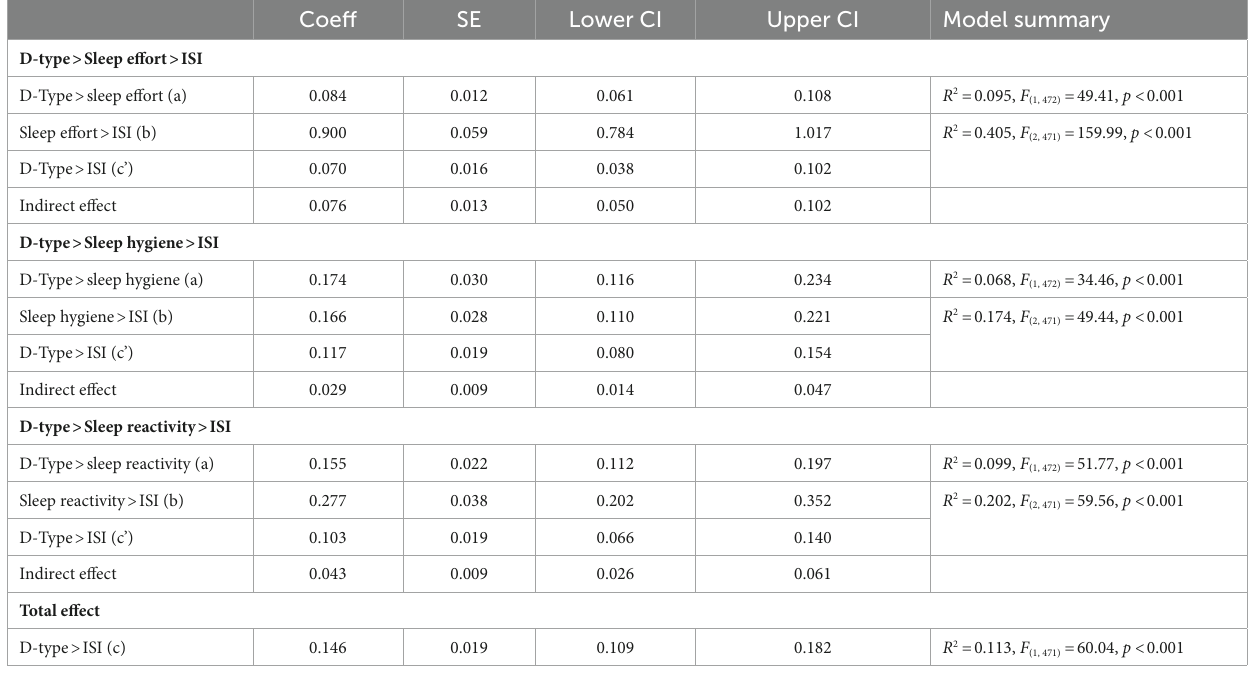
TABLE 5 Statistics for hypothesized mediation models. Coeff SE Lower CI Upper CI Model